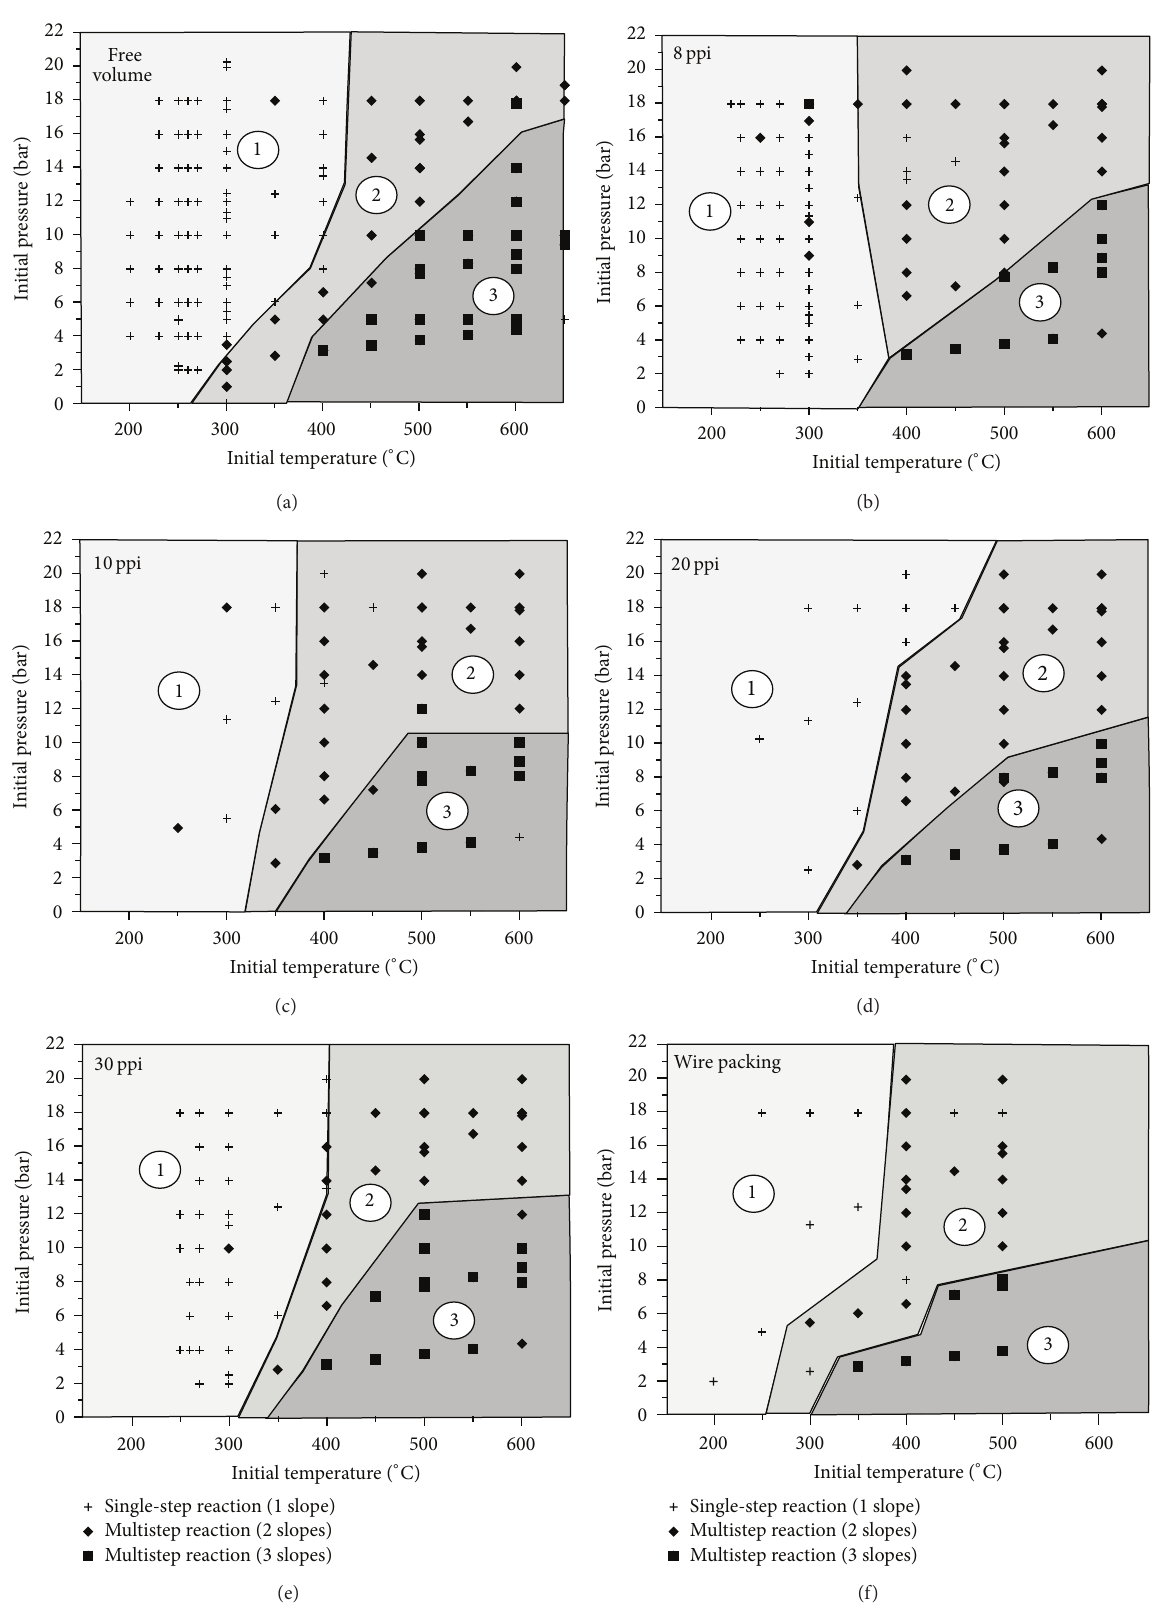
Figure 17: Fields representing characteristic combustion modes in porous reactors as compared to free Diesel injection